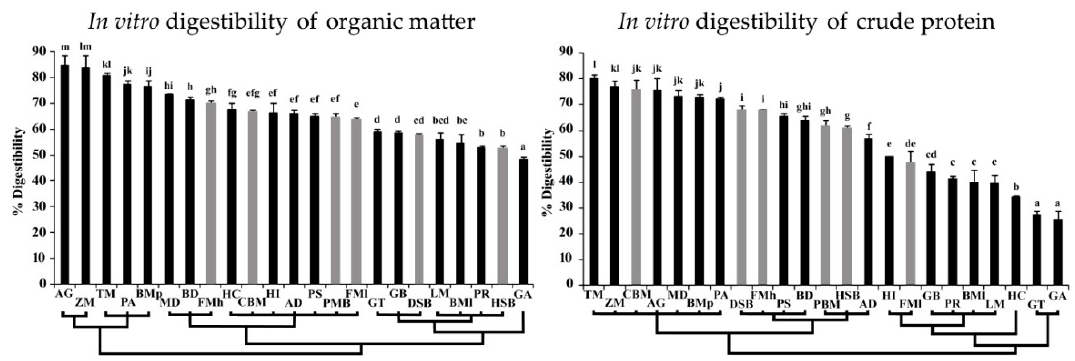
Figure 1. Dendrogram of the in vitro digestibility of organic matter and crude protein between general protein sources (grey column) and insect meal types (black column). The different superscripts on the top of column represent statistically significant differences at p < 0.05. Standard deviations are presented as error bars.